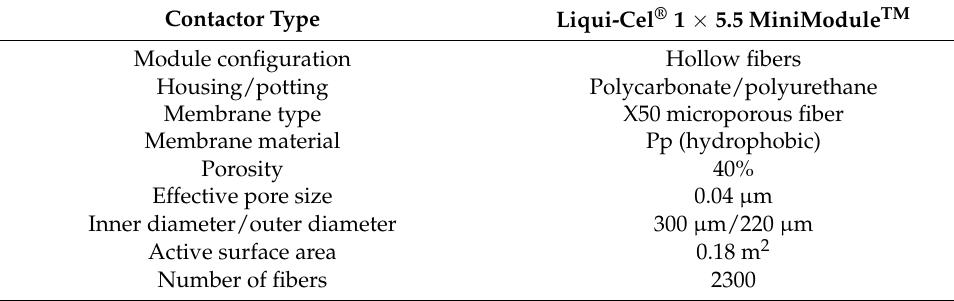
Table 1. Characteristics of the membrane contactor and hollow